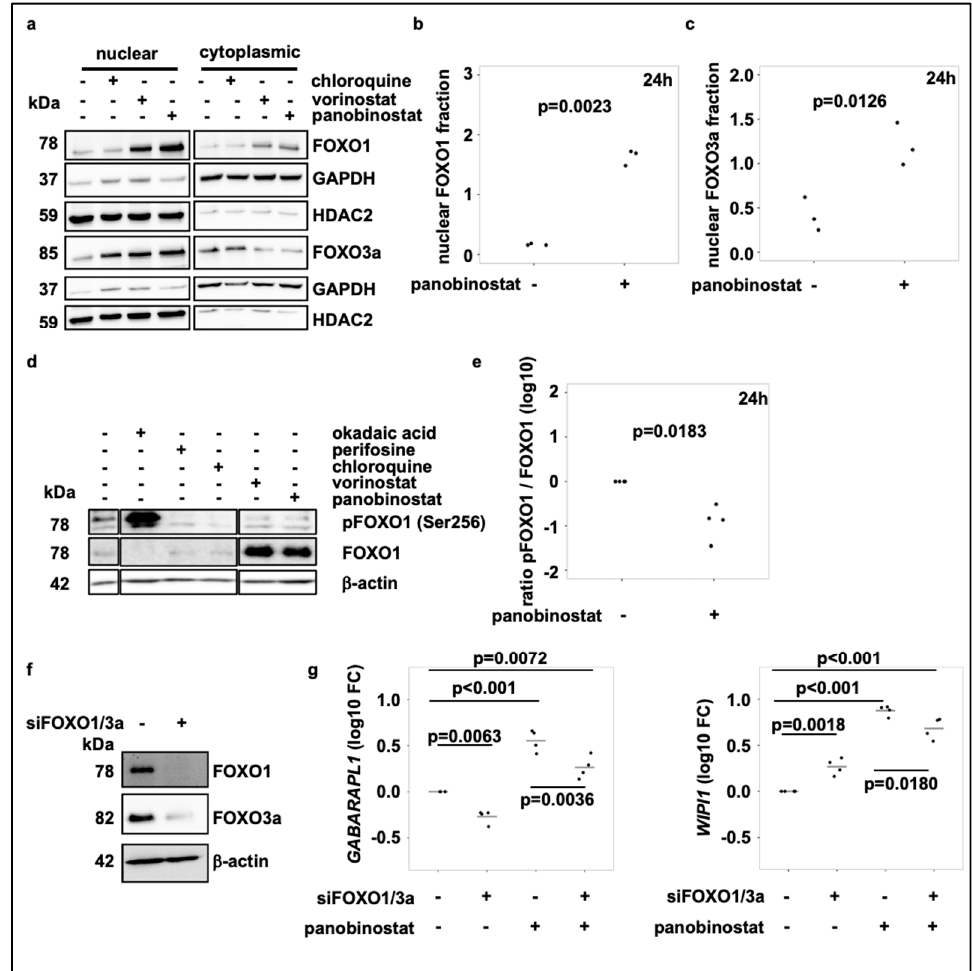
Figure 4. Broad-spectrum HDAC inhibitor treatment activates FOXO1 via the PI3K-AKT-pathway and induces FOXO nuclear translocation. ( a ) Representative subcellular localization analysis of FOXO1 and FOXO3a in SK-N-BE(2)-C neuroblastoma cells treated for 24 h with chloroquine (50 µ M), vorinostat (500 nM) or panobinostat (10 nM) for 24 h. GAPDH was used as cytoplasmic marker, HDAC2 served as nuclear marker. ( b , c ) Quantification of FOXO1 ( b ) and FOXO3a ( c ) nuclear protein of at least three individual Western blots analogous to figure ( a ). ( d ) Western blot analysis of pFOXO1 and FOXO expression after treatment of SK-N-BE(2)-C cells with chloroquine (50 µ M), vorinostat (500 nM) or panobinostat (10 nM) for 24 h. Okadaic acid (1 µ M) and perifosine (5 µ M) were used as positive and negative control, respectively. All samples were applied to the same gel and blotted on one membrane. Treatments with inhibitors/substances not relevant for the figure were cut from the analysis. ( e ) Quantification of the pFOXO1 to FOXO1 ratio from Western blot analysis from four individual experiments, normalized to solvent control. Statistical analyses: t -test. ( f ) Western blot analysis of FOXO1 and FOXO3a in SK-N-BE(2)-C neuroblastoma cells 5 days after transfection with control or FOXO1 and FOXO3a siRNA (pool of three different siRNAs for each target; pool of 6 siRNAs in total), respectively. ( g ) Realtime RT-PCR analysis of GABARAPL1 and WIPI1 after transfection of SK-N-BE(2)-C neuroblastoma cells with control or FOXO1 and FOXO3a siRNA (pool of 3 siRNAs for each target; pool of 6 siRNAs in total). Cells were additionally treated for the last 24h with either panobinostat or a solvent control. Statistical analyses: ANOVA with Tukey’s multiple comparison test.